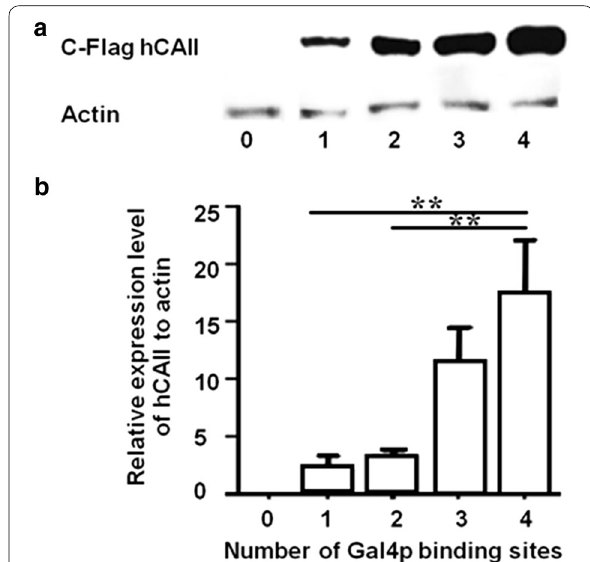
Fig. 1 Expression level of hCAII under the control of variously modified GAL1 promoters. The drug-sensitive AS03 yeast strain harboring either the empty pRS414 vector or one of the GAL1 promoter derivatives containing either one, two, three or four copies of the Gal4-binding sites (pGAL1.1_hCAII, pGAL1.2_hCAII, pGAL1.3_ hCAII or pGAL1.4_hCAII, respectively) was cultivated under